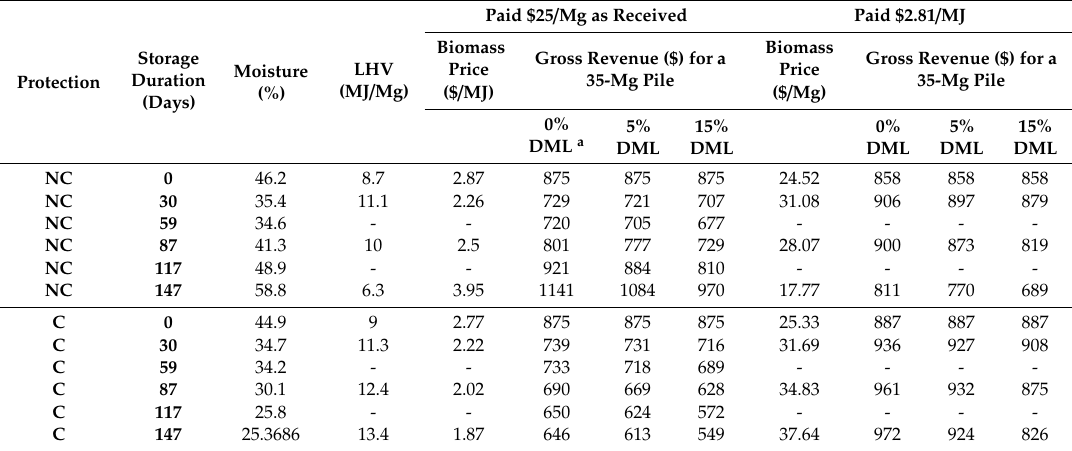
Table 3. Biomass price and gross revenue for a storage pile with fuel purchase on a wet weight basis or an energy